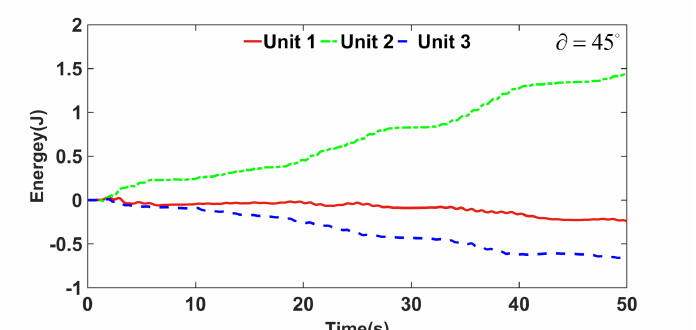
Figure 7. Variation in the wave energy harvested by each WEC unit between the interconnected and isolated systems.